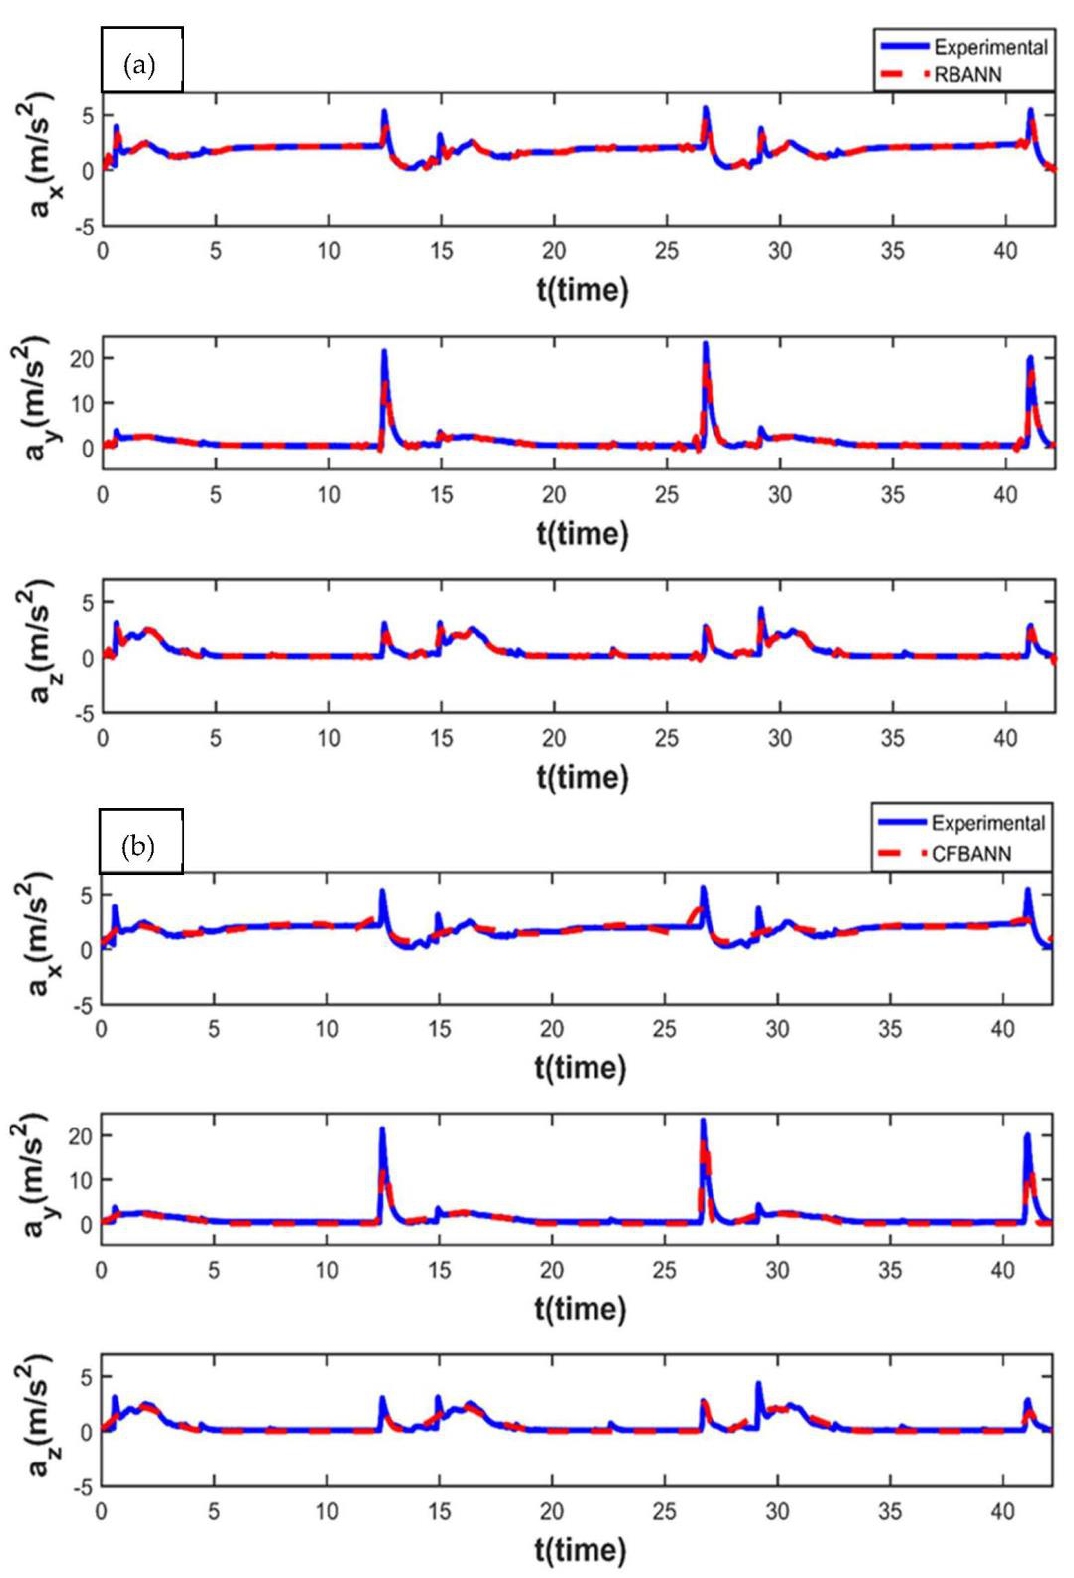
Figure 10. Experimental and ANN results obtained for the working condition of 11 s and 37.50 bar: ( a ) RBANN; ( b ) CFBANN.